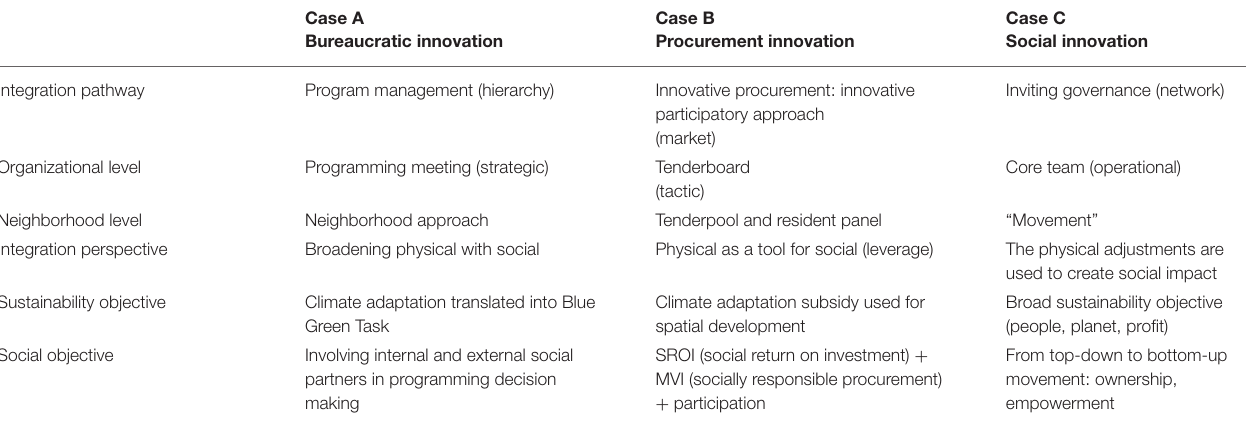
TABLE 1 | Introduction to the case